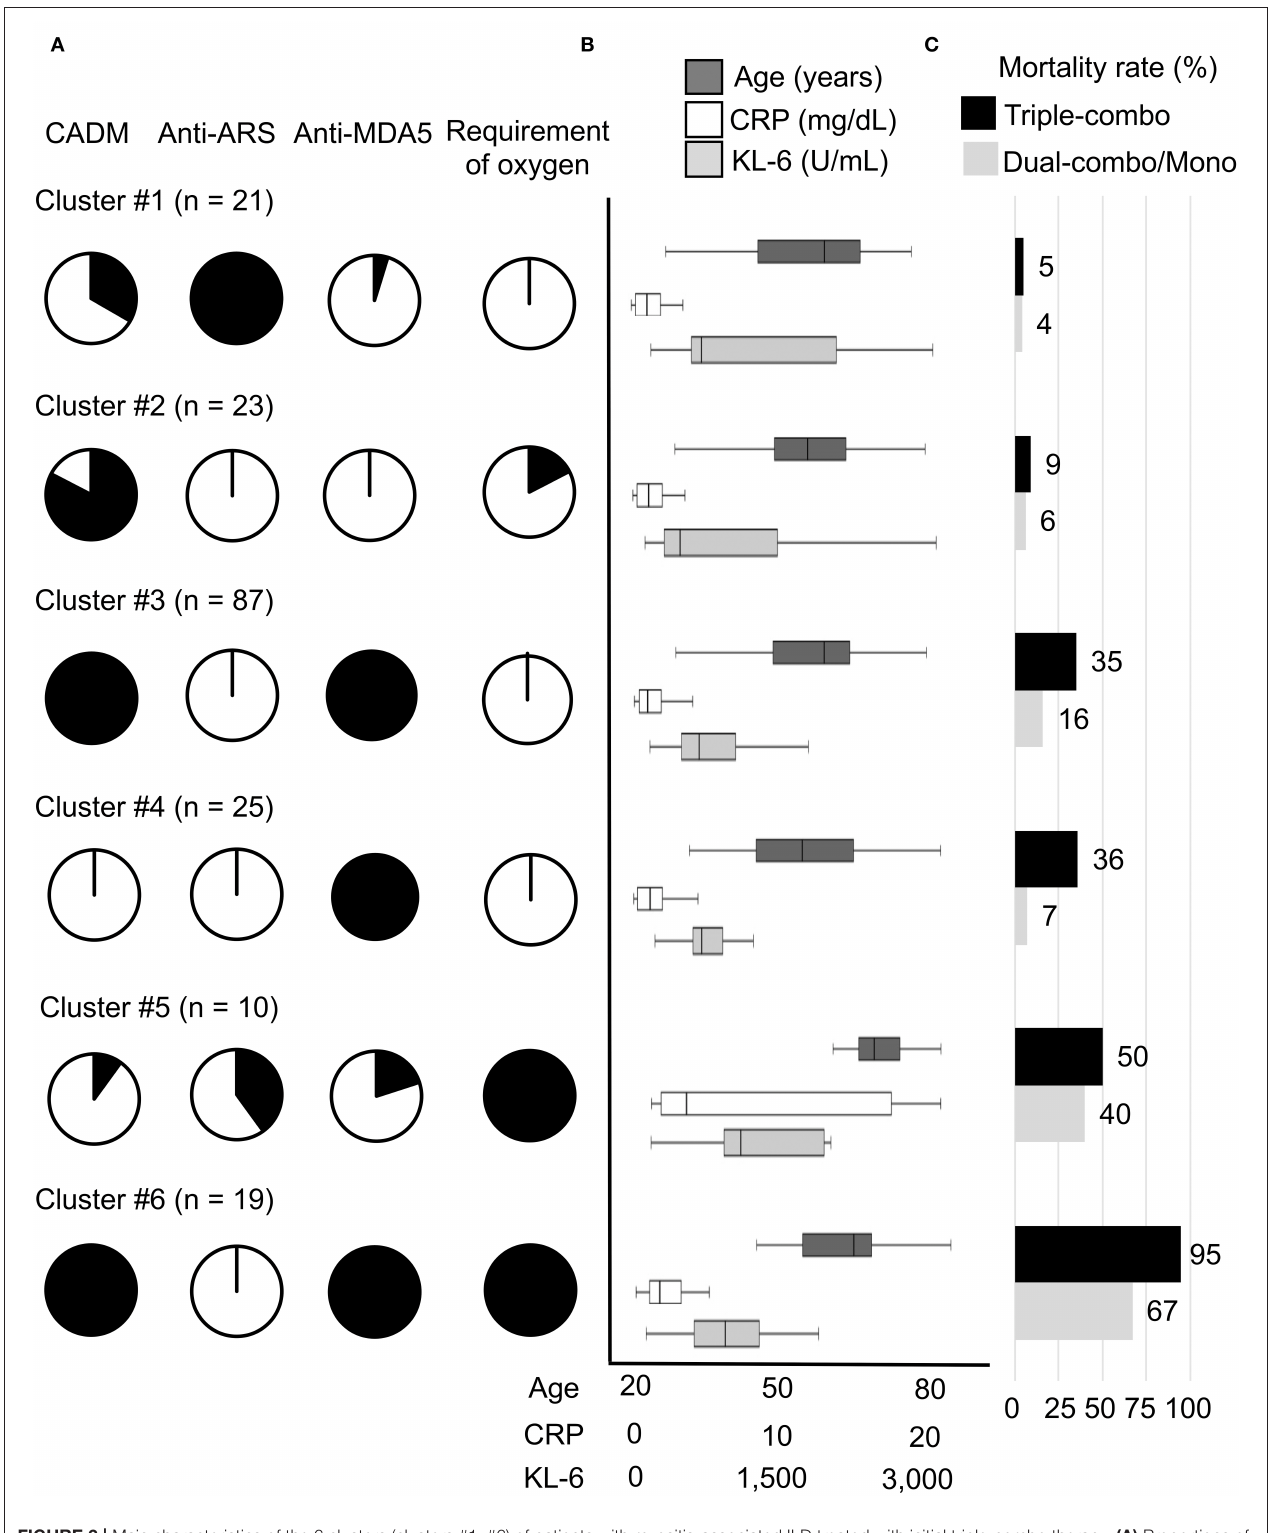
FIGURE 2 | Main characteristics of the 6 clusters (clusters #1–#6) of patients with myositis-associated ILD treated with initial triple-combo therapy. (A) Proportions of each cluster with the main clinical characteristics of clinically amyopathic dermatomyositis (CADM), anti-aminoacyl transfer RNA synthetase (ARS) antibody, anti-melanoma differentiation-associated gene 5 (MDA5) antibody, and requirement of supplemental oxygen. (B) Age at disease onset and serum levels of C-reactive protein (CRP) and Krebs von den Lungen-6 (KL-6) at diagnosis in each cluster. (C) Mortality rates during the observation period in patients treated with initial triple-combo therapy and those treated with dual-combo therapy or monotherapy in each cluster.